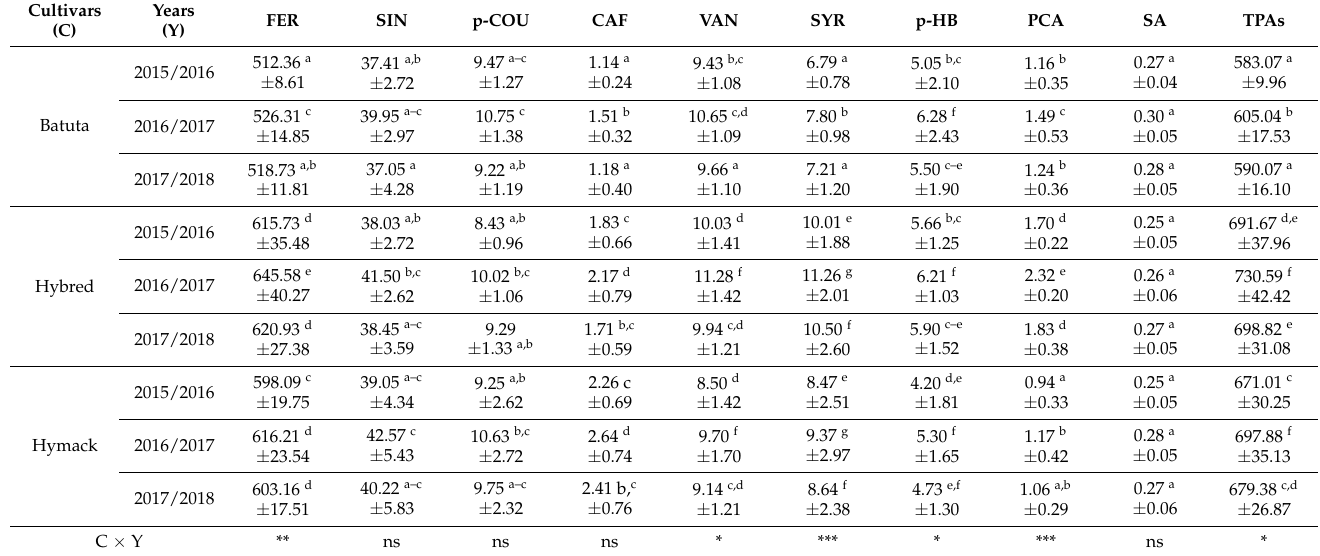
Table 6. Phenolic acid (PA) composition of wheat grain [ µ g g − 1 ], mean values for interaction cultivars ×